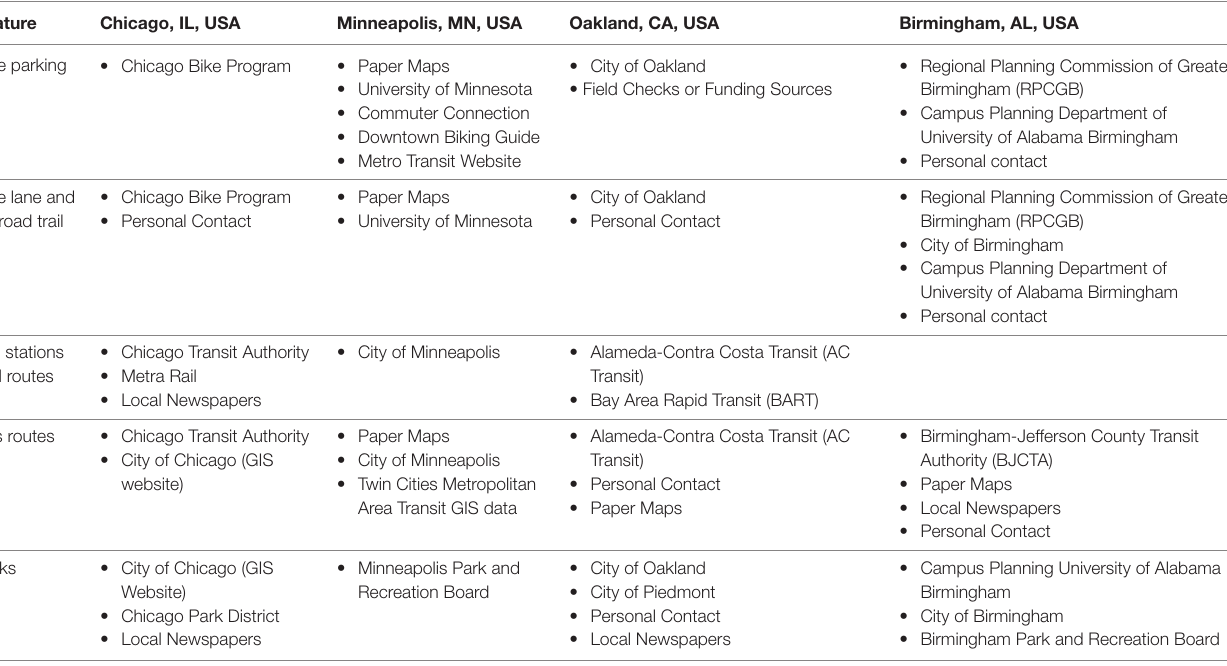
tABLe 1 | sources of information for the four cities study field audit.